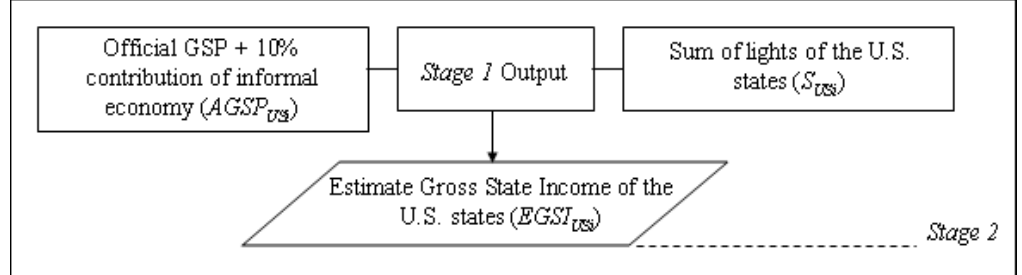
Figure 6. Stage 2 of the model: outputs are Estimated Gross State Income of the U.S. states and multiple regression model parameters used to estimate the Gross State Income of the Mexican states in Stage 4 of the model.